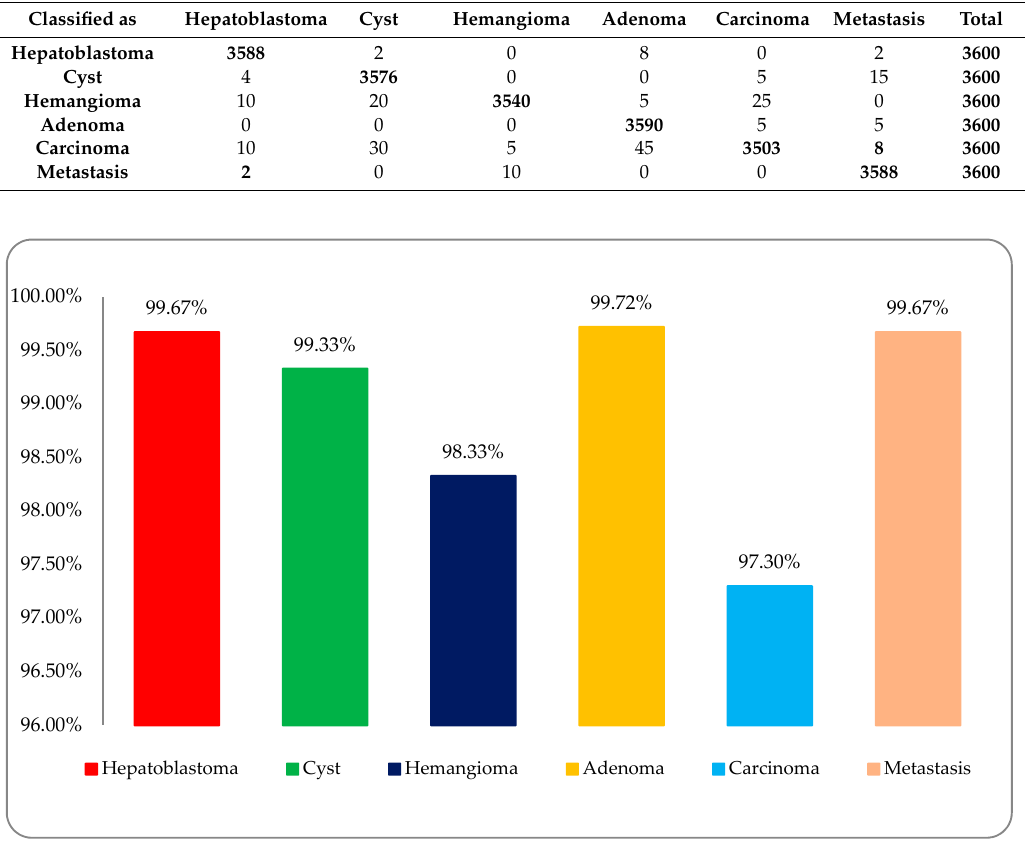
fused optimized dataset.